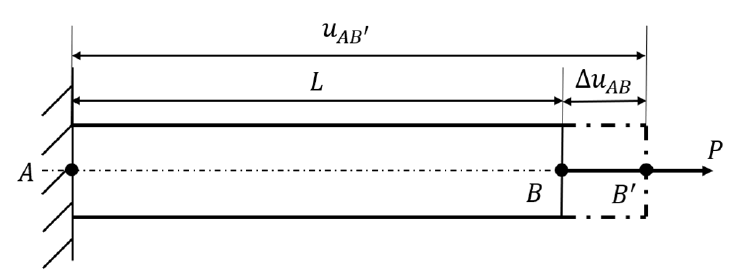
Figure A1. Elongation of a beam.